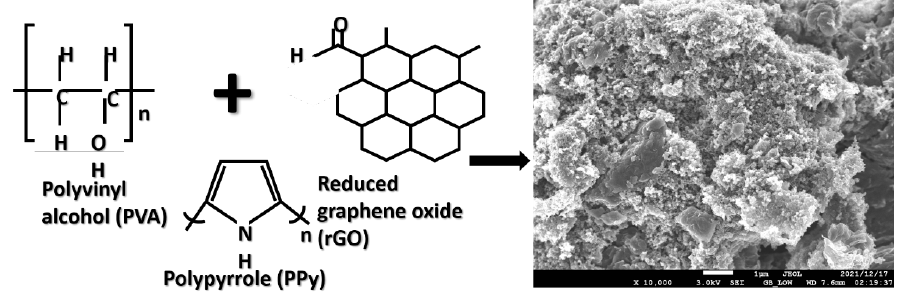
Figure 1. The structures and the morphology of PVA/PPy/rGO nanocomposite (0.4 (wt%)).